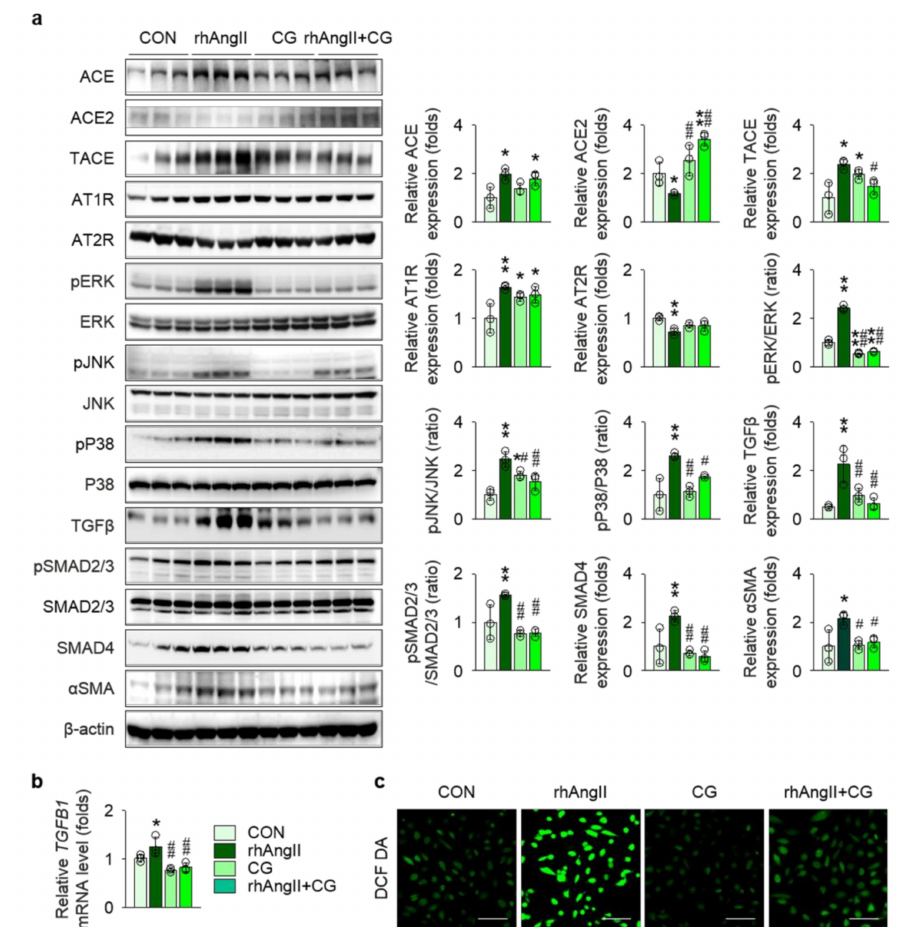
Figure 7. CG abrogated activation of RAS and TGF β signals in Ang II-stimulated HK-2 cells. ( a ) Comparison of protein expression level for RAS components, MAPKs, and TGF β and its downstream molecules in HK-2 after stimulation with vehicles or recombinant human Ang II (rhAng II) with or without co-treatment of CG ( n = 3 / group). β -actin was used as the endogenous control. Data are representative more than three independent experiments. ( b ) Comparison of mRNA expression level for TGFB1 determined by qPCR in HK-2 after stimulation with vehicles or recombinant human Ang II (rhAng II) with or without co-treatment of CG ( n = 3 / group). GAPDH was used as the endogenous control. ( c ) Representative images of 5,6-chloromethyl-2 (cid:48) ,7 (cid:48) -dichlorodihydrofluorescein diacetate (DCF DA) staining in HK-2 after stimulation with vehicles or recombinant human Ang II (rhAng II) with or without co-treatment of CG. Data are representative more than three independent experiments. Scale bars, 200 µ m. * p < 0.05, ** p < 0.01 vs. control cells (CON); # p < 0.05, ## p < 0.01 vs. rhAng II-treated cells by one-way ANOVA with Newman–Keuls multiple comparison